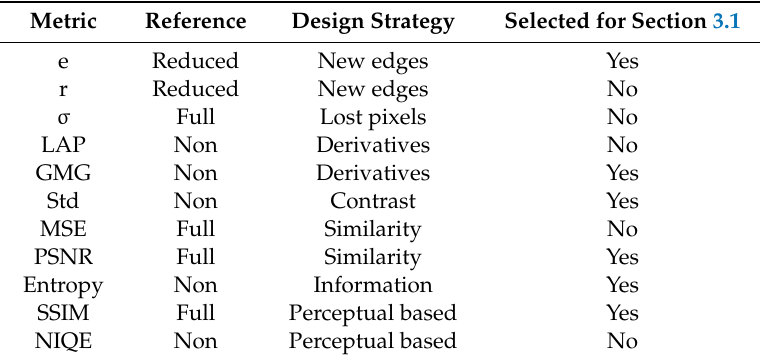
Table 1. Summary of metric classification